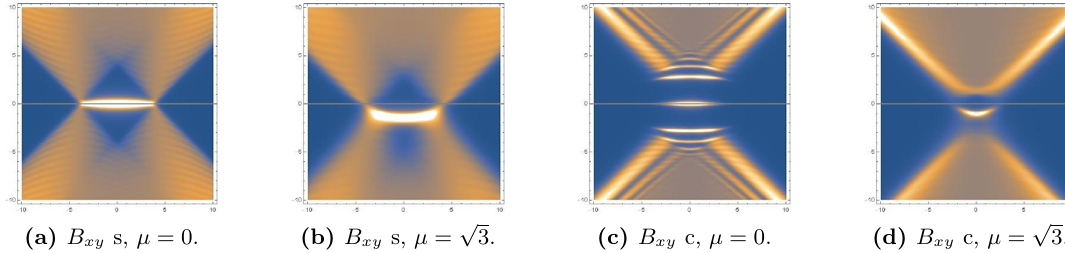
Figure 17. (a,b): SF with only source B xy with one flavor. Notice the presence of the flat band of disk-shape, which is bent down in the presence of chemical potential; (c,d): SF with only condensation B xy . All figures here have cylindrical